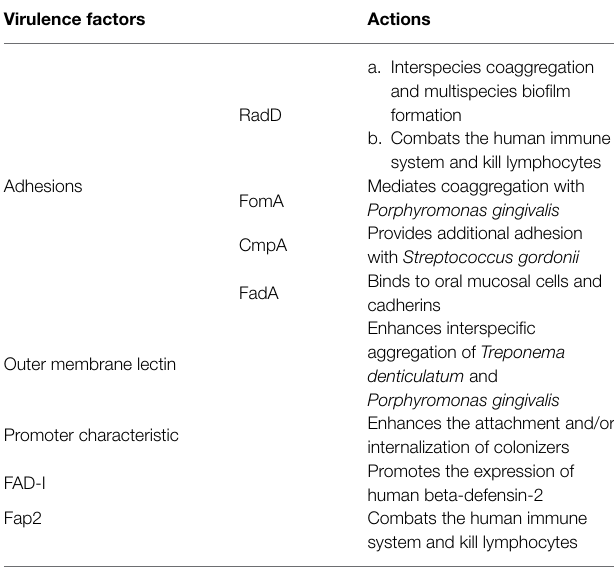
TABLE 1 | Virulence factors of Fusobacterium nucleatum in periodontal diseases. Virulence